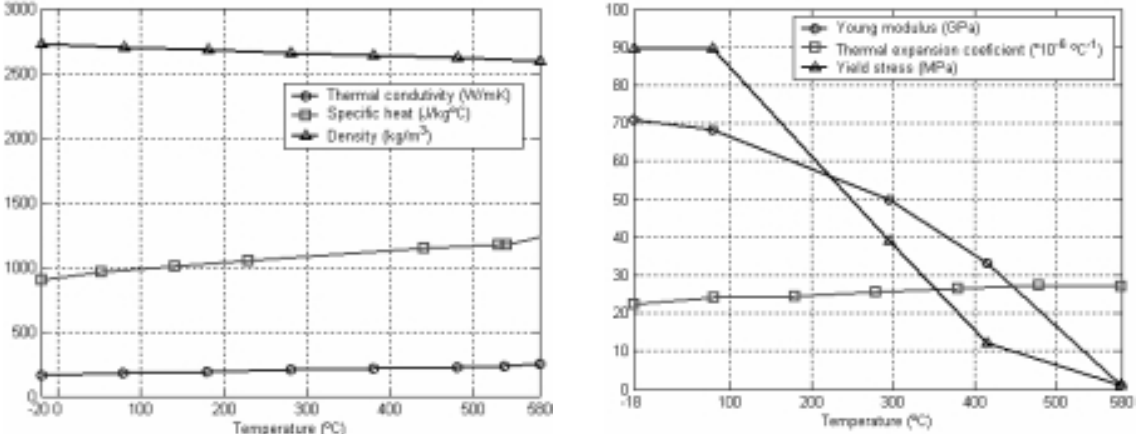
Fig. 2. Physical properties of aluminum 5052 as functions of temperature (adapted from [21]).